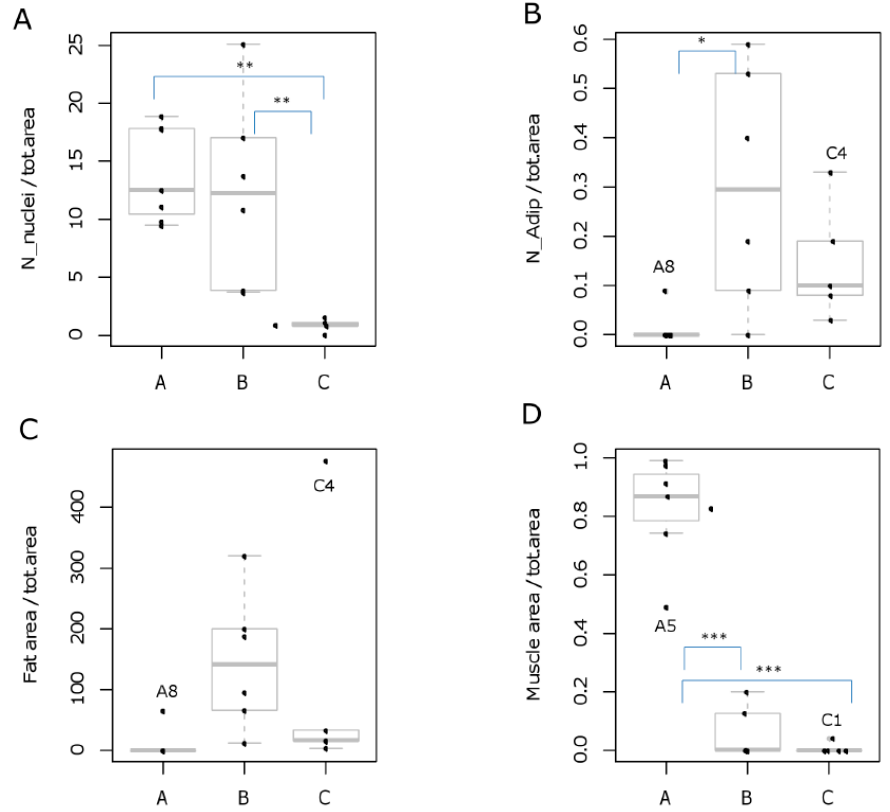
Figure 2. Statistical analysis of histomorphometry of A, B and C samples. Samples were analyzed after 1 H HR-MAS NMR acquisition to evaluate the number of nuclei ( A ); number of adipocytes ( B ); fat area ( C ); and muscle area ( D ). All data were normalized to total area and box-whisker plots were used to visualize the results. The bars outside the plot represent data outside 1.5 times the IQR (interquartile range), and points outside the bars are outliers. Outlier samples are identified with a label. Statistical significance was evaluated by ANOVA (Tukey’s post-hoc tests, * p < 0.05, ** p < 0.01, *** p < 0.001).